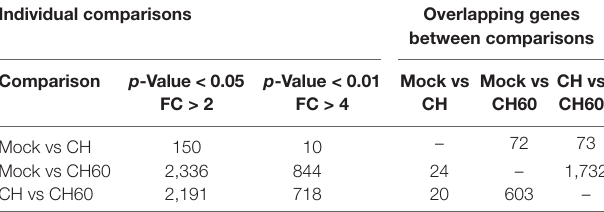
*Number above “–” indicates DEG at p-value < 0.05 and fold change > 2 between indicated comparisons. Number below “–” indicates DEG at p-value < 0.01 and fold change > 4 between indicated